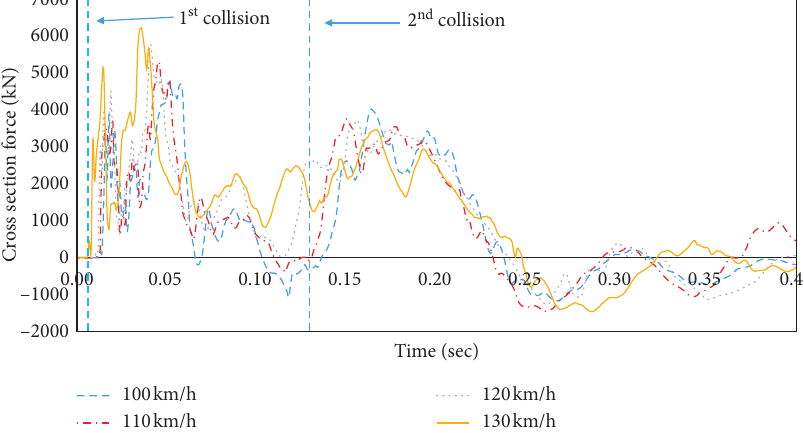
Figure 13: Load-time history graph of the bridge column (column type